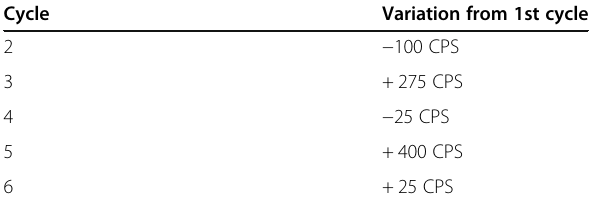
Table 4 IMS2, Configuration Variations, Cycles 2 – 6 Cycle Variation from 1st cycle